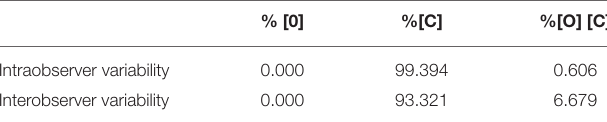
TABLE 2 | Values of correlation coefficients and concordance index. TABLE 3 | Values associated with each facet in intra- and inter-observer reliability.